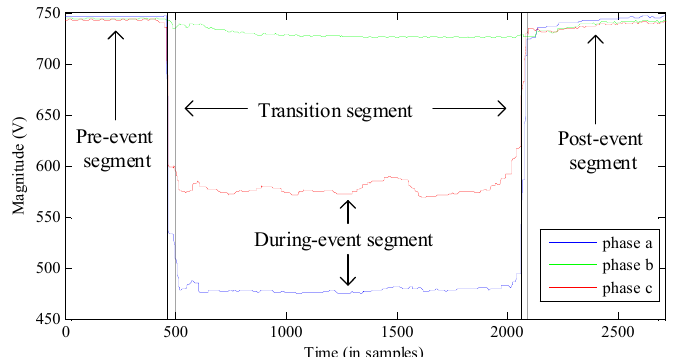
Figure 1. A typical voltage sag waveform with several segments.